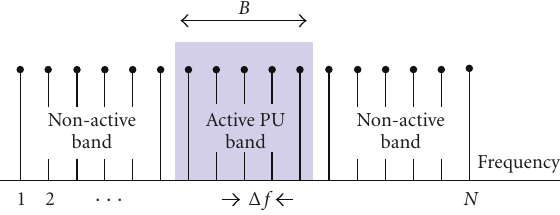
Figure 13: Frequency distribution with one active PU band.